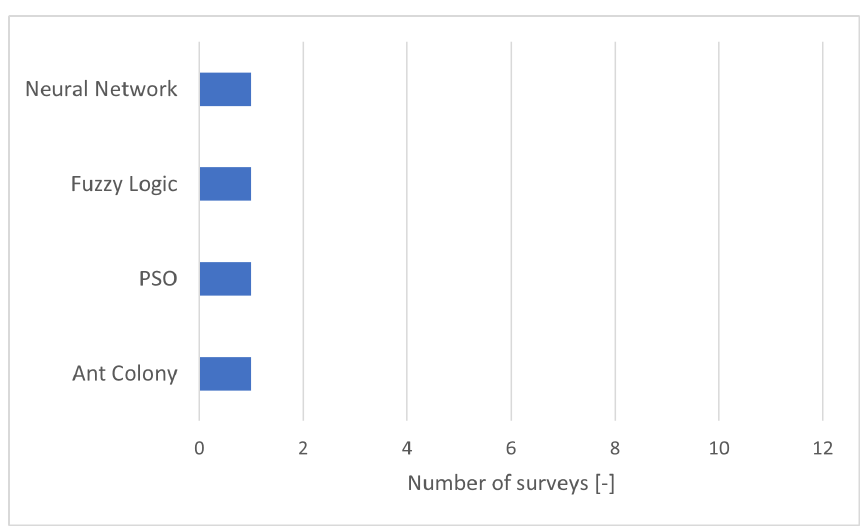
Figure 9. Artificial intelligence methods in real